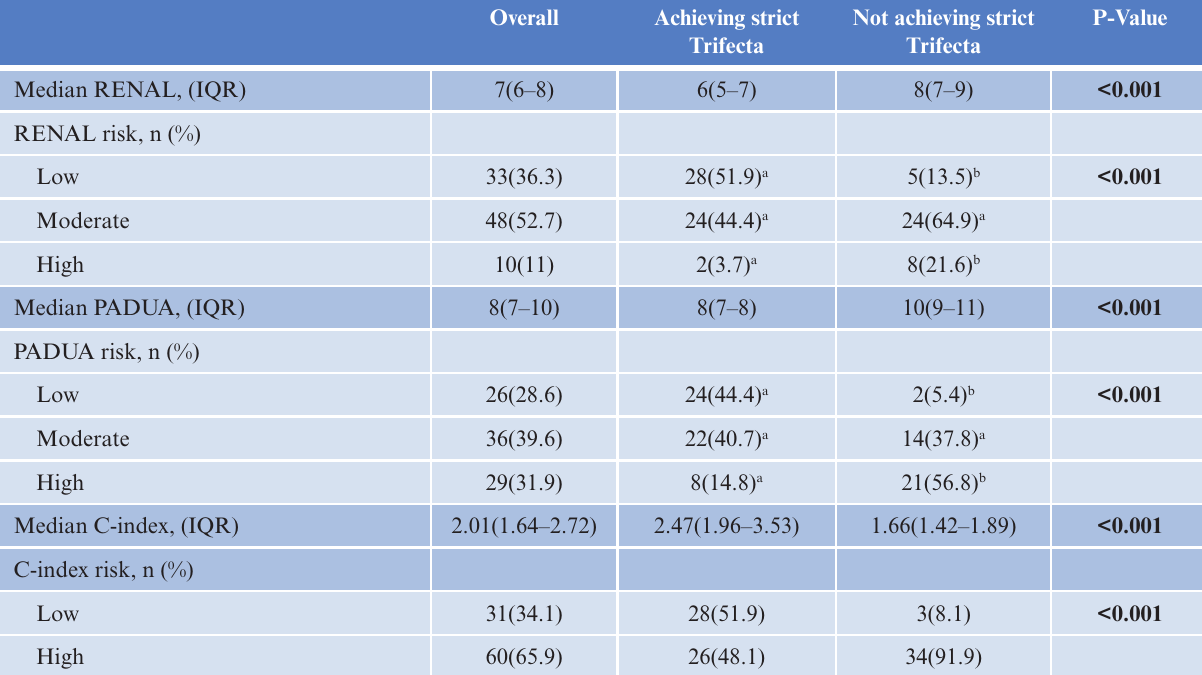
Table 3: Overall nephrometry scores and